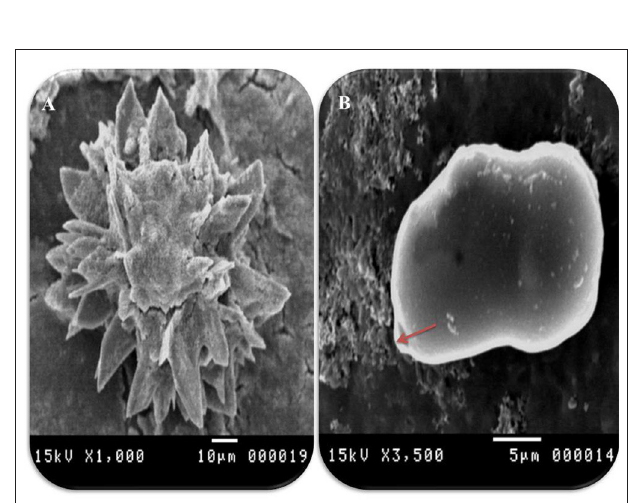
FIGURE 5 | Morphometric appearance of hydatid cyst isolated from cattle lung using SEM. (A) SEM of rostellar hooks from protoscoleces of hydatid cyst, isolated from cattle showing alternating large and small hooks, and (B) SEM of brood capsules showing exterior outgrowth in hydatid cyst isolated from a cattle lung